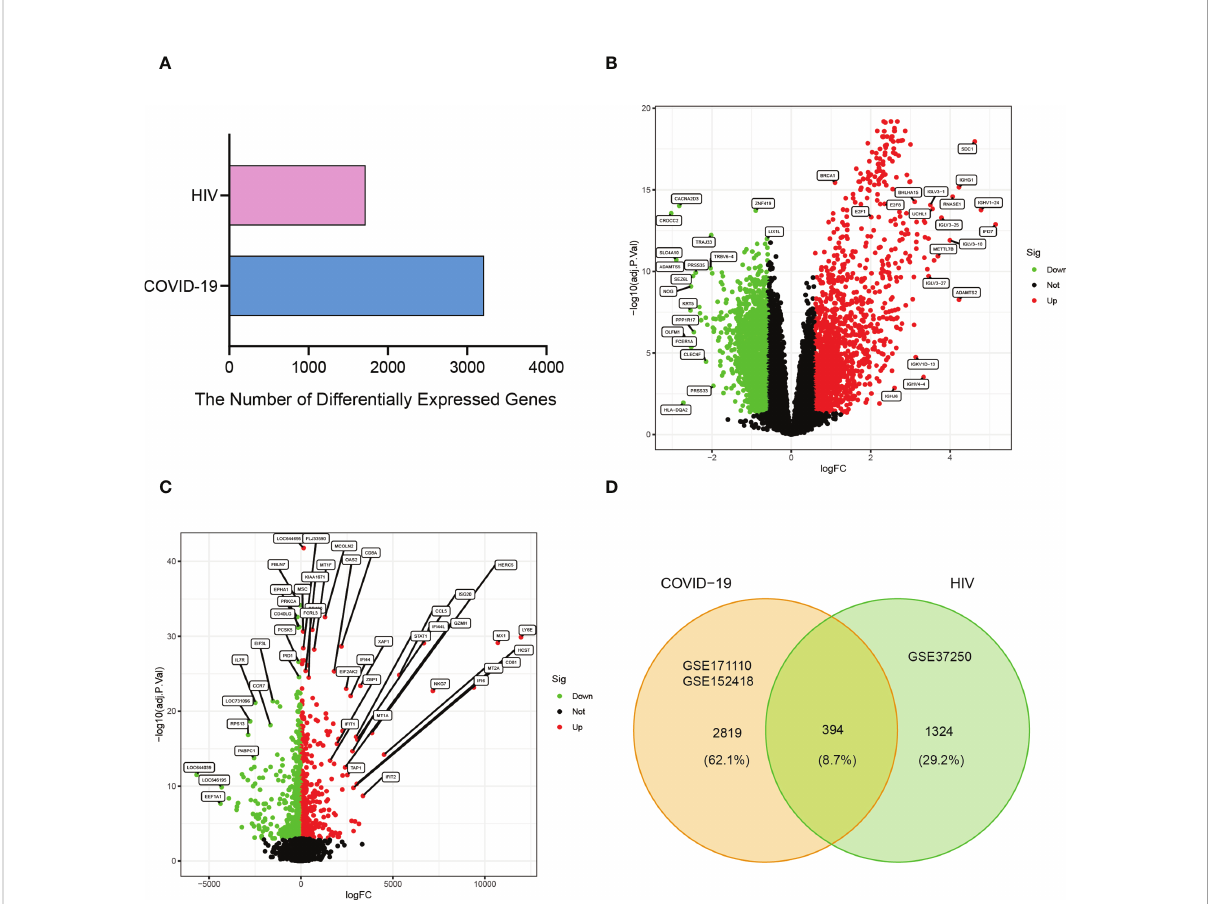
FIGURE 2 Visualization the number of common differentially expressed genes between two datasets, COVID-19 (GSE171110 and GSE152418) and HIV (GSE37250). (A) Comparing the number of differentially expressed genes between COVID-19 and HIV. (B) The volcano plot of differentially expressed genes in COVID-19 datasets. (C) The volcano plot of differentially expressed genes in the HIV dataset. (D) Venn diagram showing the overlap of differentially expressed genes between COVID-19 and